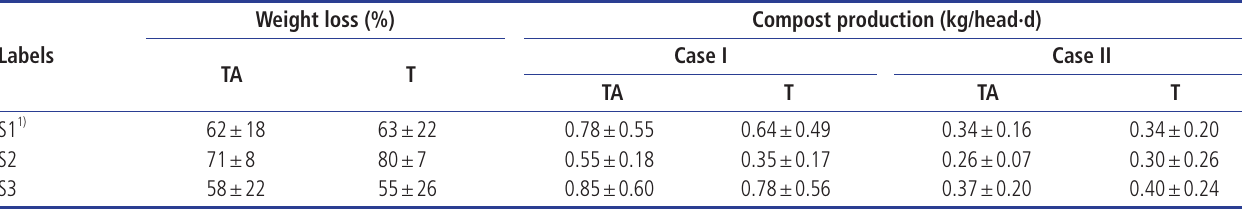
TA, turning and aeration methods together; T, turning method only. 1) S1, weight loss scenarios; S2, measurement in the field; S3, volume reduction from Reference; no changes of theoretical phosphorus. Values are represented mean±standard